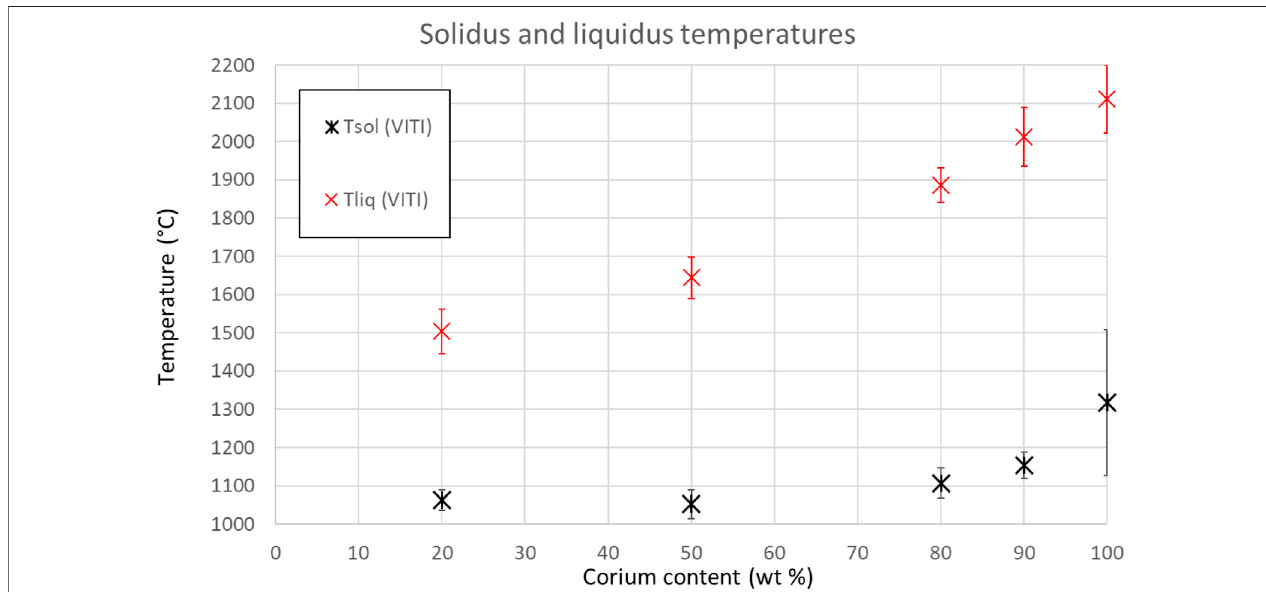
FIGURE11| VITI-VPAsolidusandliquidustemperaturemeasurements,accordingtocoriumcontentinCorium-Sacri fi cialMaterial(CSM)mixtures(Delacroix,etal.,